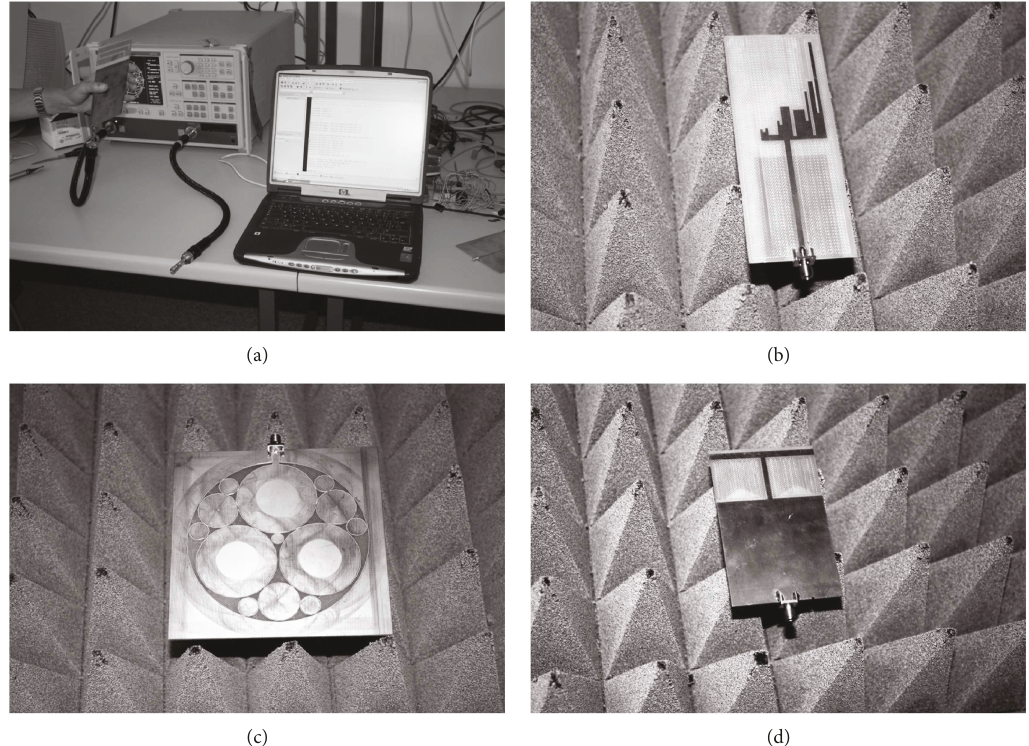
Figure 2: Setup elements. (a) Details of the hand and the capture system (PC+ GPIB+ VNA). (b) Single-sided fractal antenna (Cantor model). (c) CPW-fed printed slot antenna (Descartes model). (d) Double-sided printed antenna (T-monopole